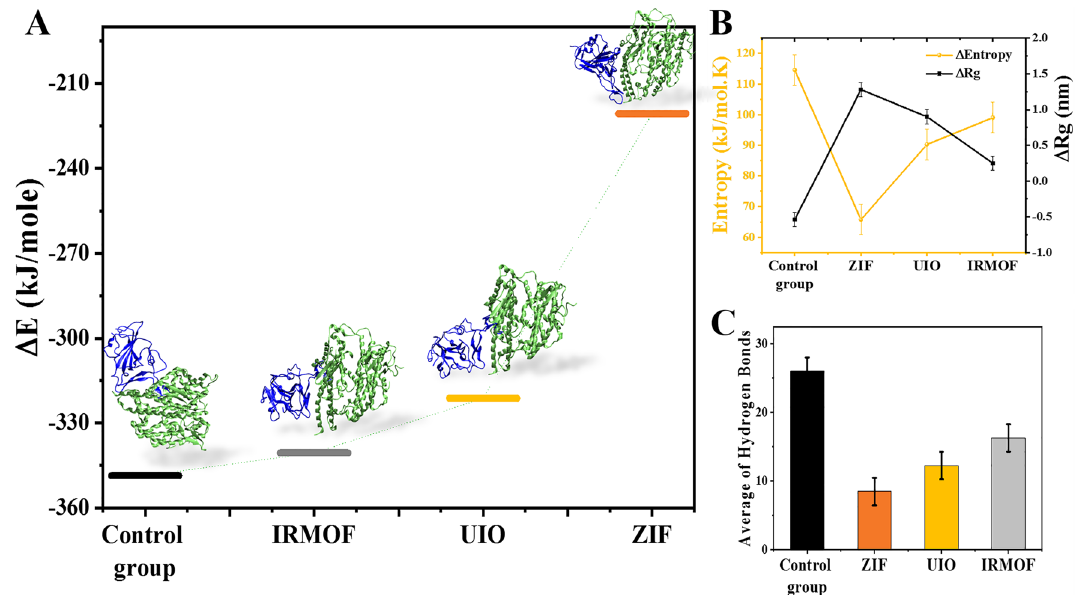
Figure 4. ( A ) Docking interaction energy of (deformed) SPs with ACE2 accompanied with snapshots from simulations. ( B ) Different between final and initial entropy of spike protein–ACE2 interaction as well as Rg of the spike protein. ( C ) Average of hydrogen bonds formed between spike protein and